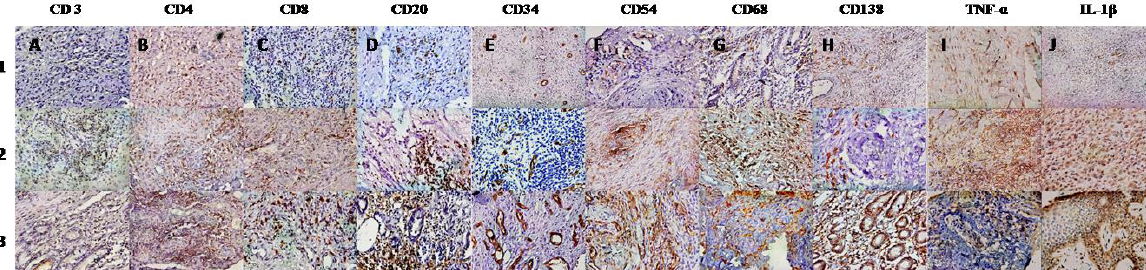
Figure 2. Immunohistochemistry of knee synovium from arthritis patients showing varying grades (1 – 3) of severity of inflammation and infiltration by various inflammatory cells. Immunohistochem- istry of knee synovium from arthritis patients (1, 2, and 3) showing varying grades of infiltration by various inflammatory cells-. T cells (CD3, CD4, CD8) (lane A , B , C respectively); B cells (CD 20) (lane D ), plasma cells (CD138) (lane H ); and macrophages (CD 68) (lane G ). Cells expressing adhesion molecule ICAM-1(CD54) (lane F ), TNF- α (lane I ) and IL- 1β (lane J ) are also shown. Immunostaining for endothelial cells (CD34) (lane E) shows the varying density of micro vessels in the synovial tis- sue.